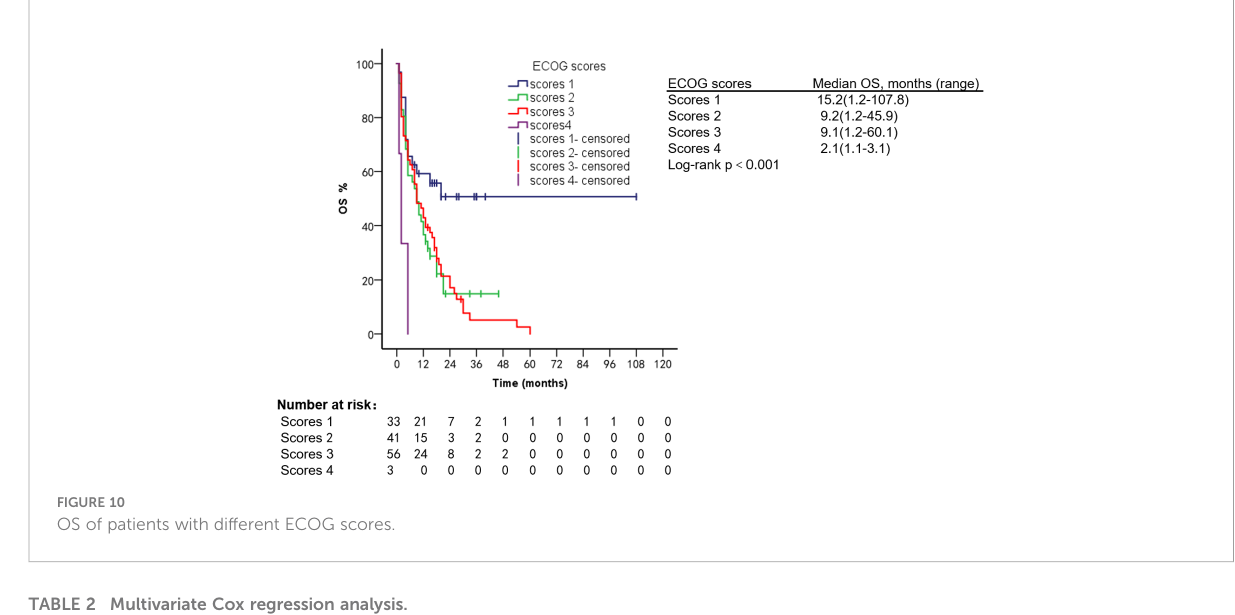
TABLE 2 Multivariate Cox regression